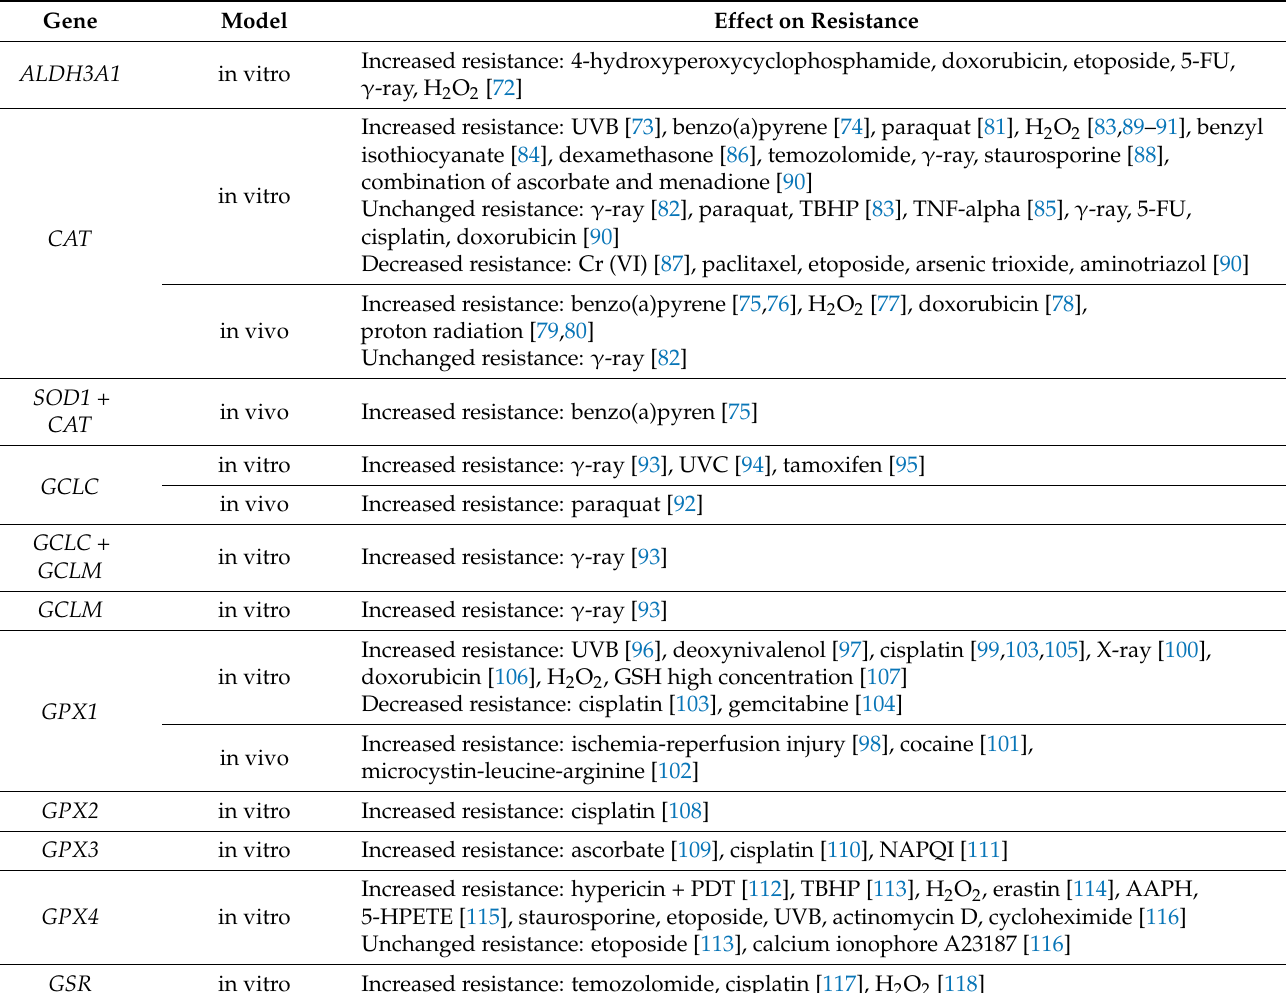
Table 1. Influence of antioxidant gene overexpression on resistance to oxidative and genotoxic stress factors in vitro and in